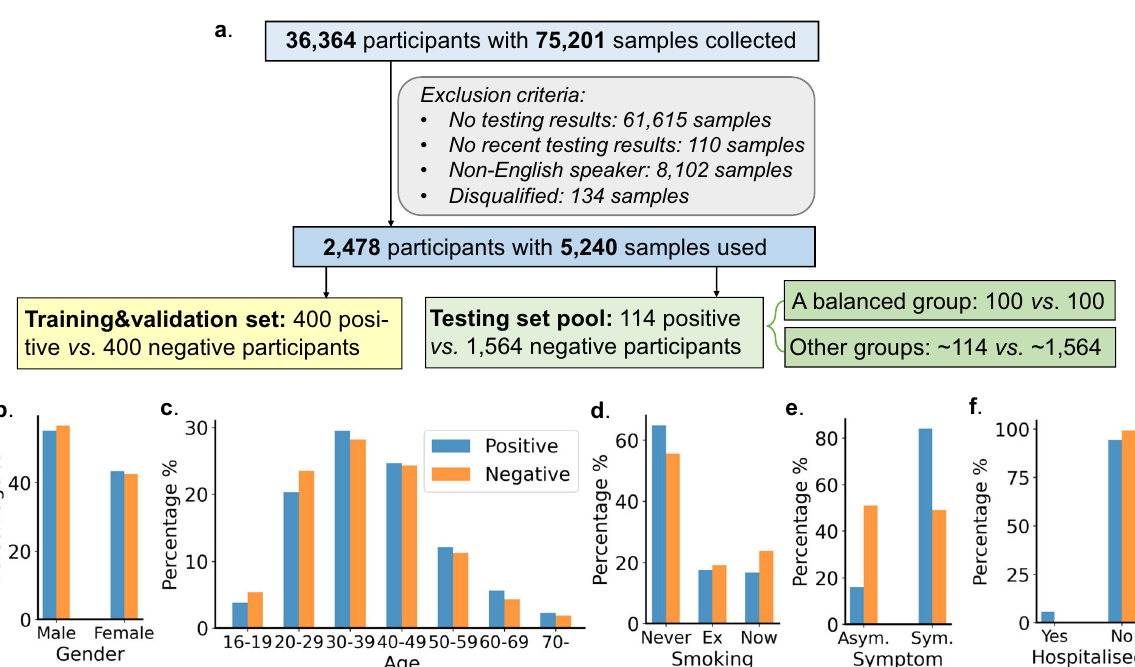
Fig. 1 Data fl ow diagram and demographic statistics. a Data cleaning and selecting with 514 COVID-19 positive and 1,964 COVID-19 negative participants eventually included for experiments. b – e Demographic statistics for the included 2478 participants with blue representing positive class and orange -- negative class: b Gender distribution with about 56% male, 43% female and 1% preferring not to say both two classes. c Age distribution with more than 87% positive and negative participants aged 20-59. d Smoking history with more than half participants never smoking and the remaining participants having smoked before or smoking currently. e symptom distribution: 16% of the positive group showed no symptoms, while 49% of the negative group reported at least one of the symptoms. f Hospitalisation: among all the tested participants, only 29 positive and 10 negative participants reported to be in a